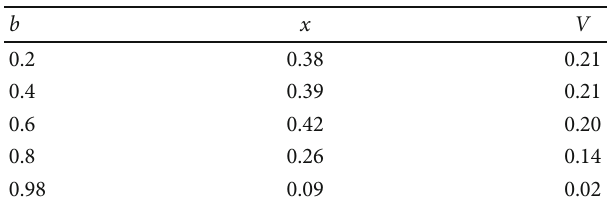
Figure 7: Considering the total potential in the pair production process, at (a) di ff erent values of temperature and (b) di ff erent values of λ . Table 2: Maximum values of V and x for di ff erent values of b tot for λ = 0 : 5 .